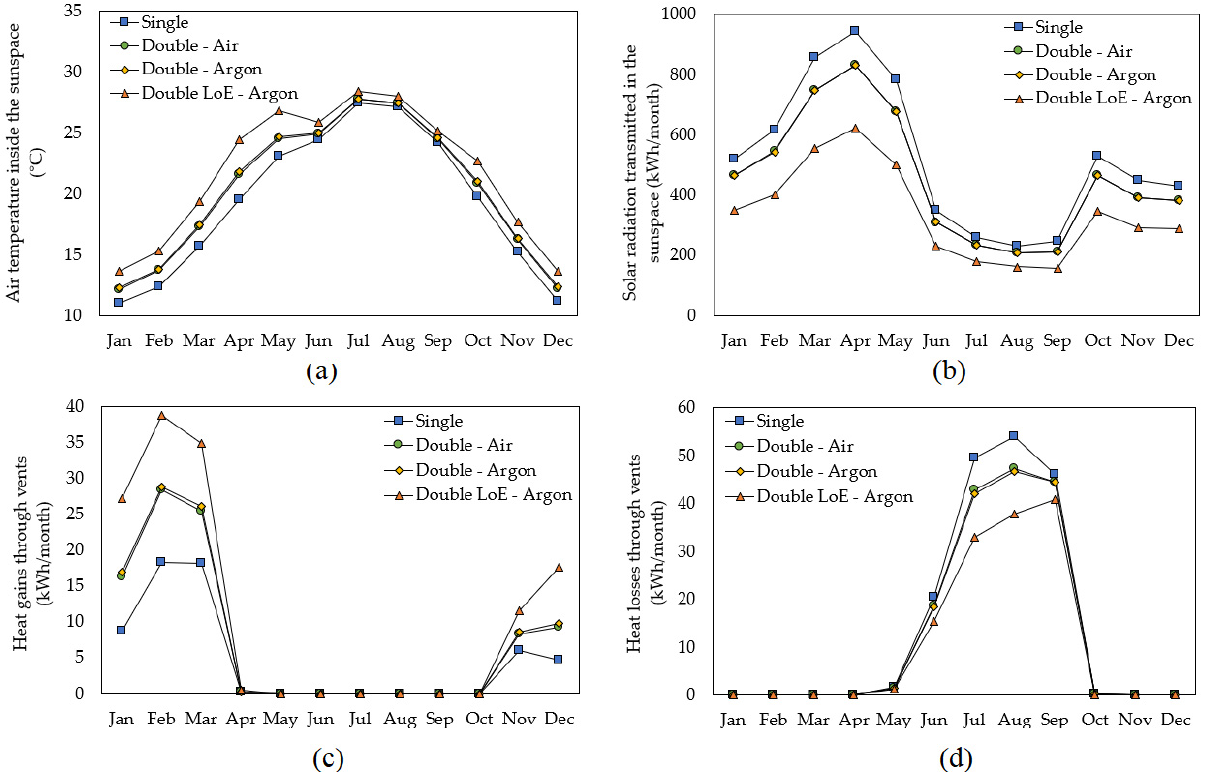
Figure 7. Glazing type analysis: ( a ) Monthly average air temperature inside the sun space; ( b ) monthly average solar radiation transmitted in the sun space; ( c ) monthly average living room heat gains through vents; ( d ) monthly average living room heat losses through vents.